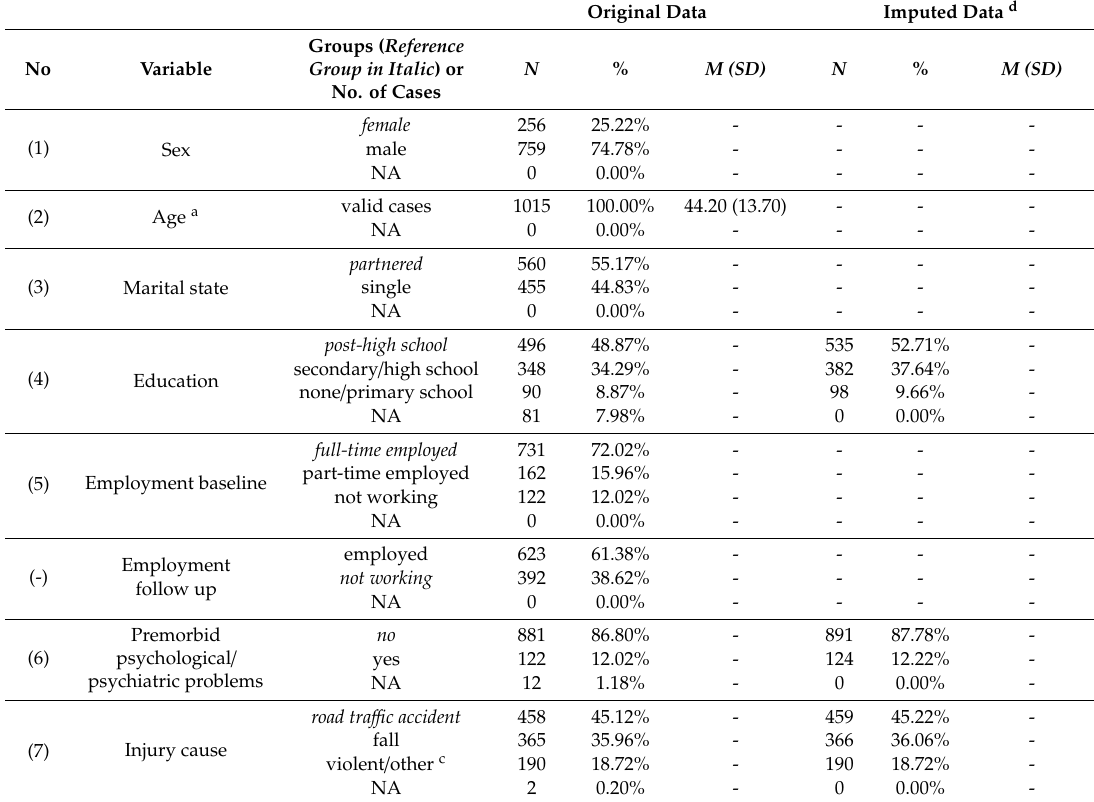
Table 1. Descriptive statistics for dependent and independent variables (factors and factor